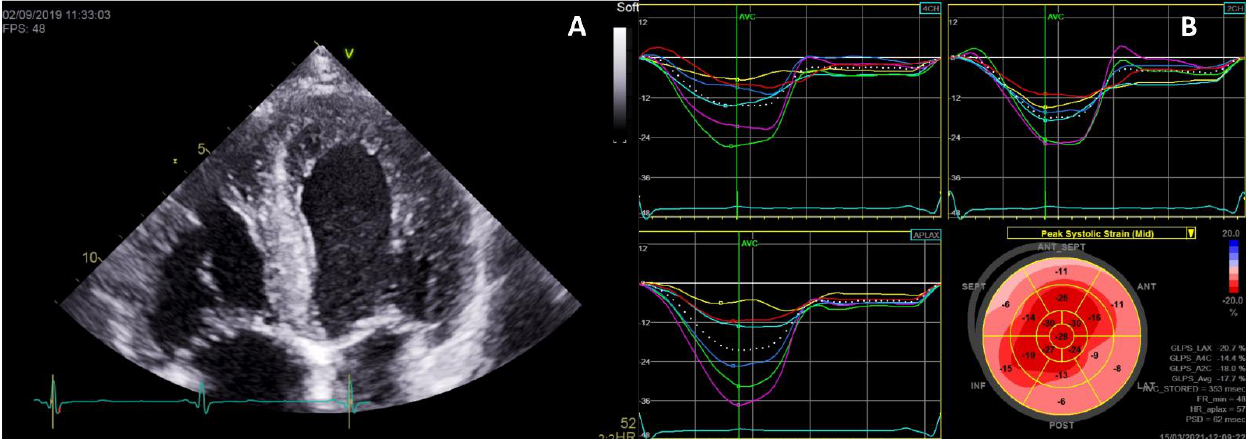
Figure 5. Apical sparing pattern of global longitudinal strain (GLS) in a Fabry patient. Transthoracic echocardiogram of a 48-year-old male Fabry patient showing symmetrical LVH in a four-chamber view ( A ) and 2 D-strain analysis by speckle tracking revealing an apical sparing pattern of GLS ( B ).